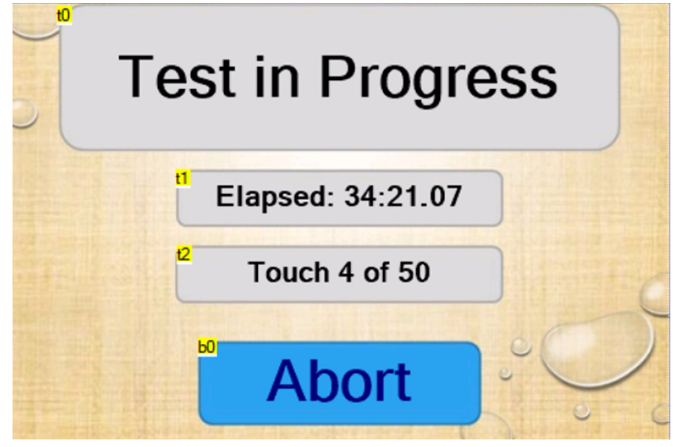
Figure 4. Test page as it appears during a